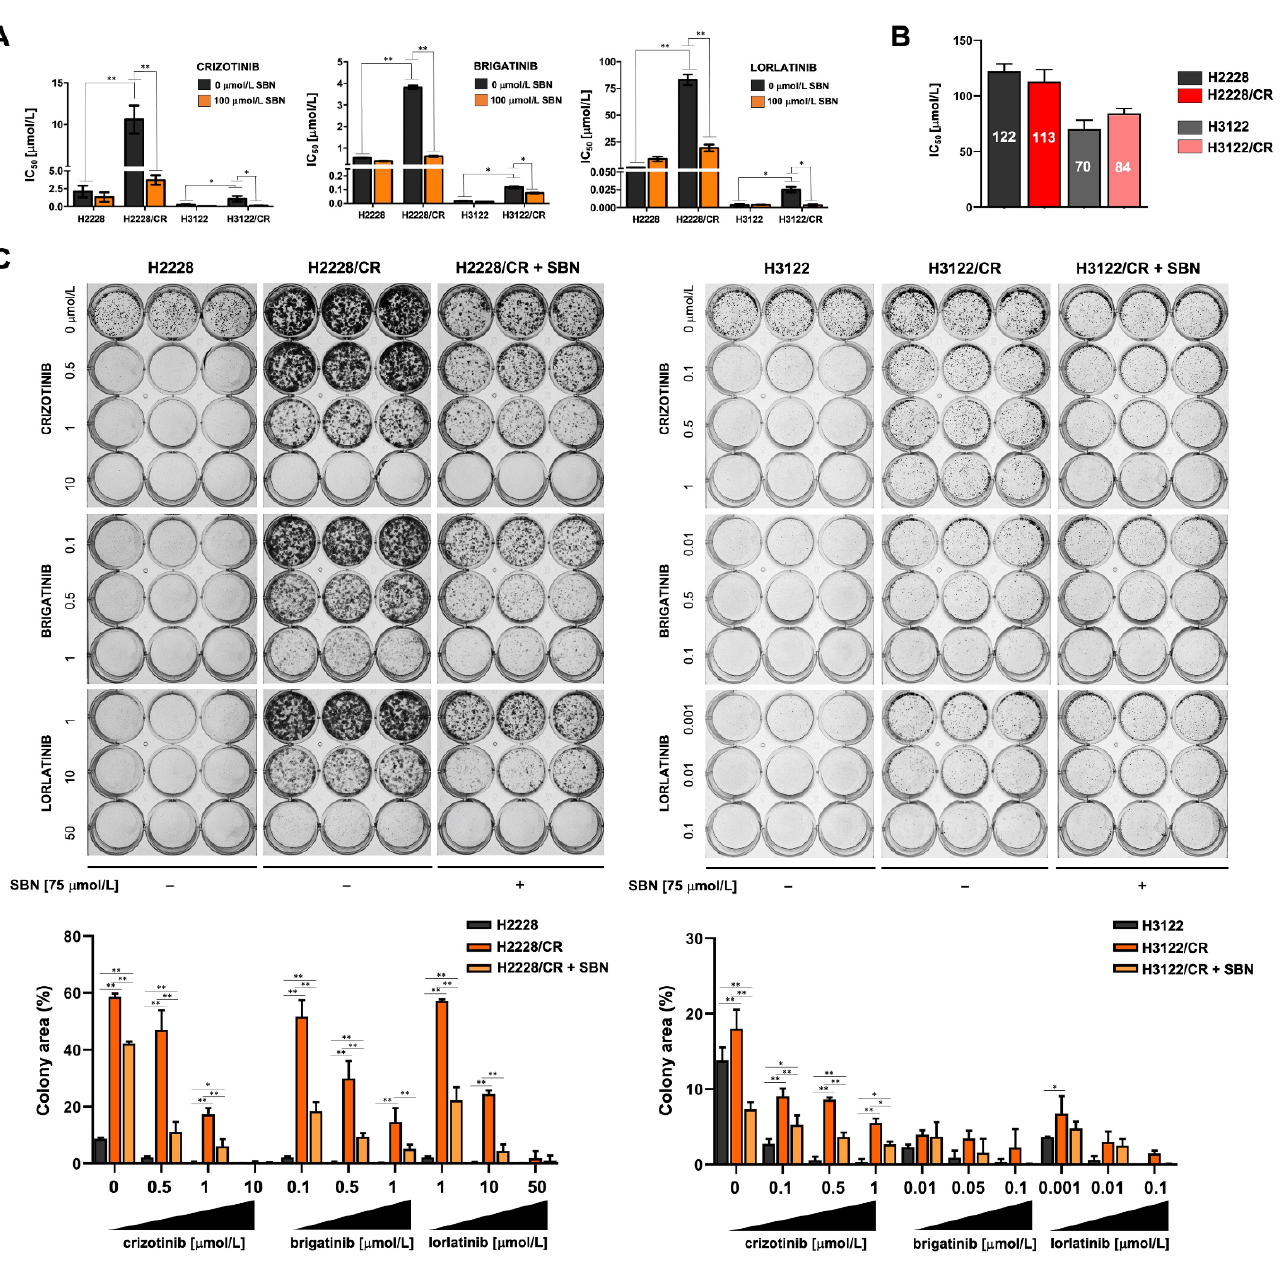
Figure 2. Sensitizing effects of silibinin against EMT-related acquisition of cross-resistance to multiple-generation ALK–TKIs. ( A ) Bar graphs showing the MTT-based IC 50 values of crizotinib, brigatinib, and lorlatinib for H2228/H2228CR and H3122/H3122CR cells calculated in the absence or presence of 100 µ mol/L of silibinin. ( B ) Bar graphs showing the MTT-based IC 50 values of silibinin in H2228/H2228CR and H3122/H3122CR cells. The results in A and B are presented as the means ( columns ) ± S.D ( bars ) ( n = 5, in triplicate). * p < 0.05 and ** p < 0.005, statistically significant differences; n.s. not significant. ( C ) Top: Representative images of clonogenic survival analyses (7 days) of H2228/H2228CR (left) and H3122/H3122CR cells (right) in response to graded concentrations of ALK–TKIs in the absence or presence of 75 μ mol/L silibinin. Bottom: Colony area (%) was calculated using the ImageJ plugin “ColonyArea”. The results are presented as the means ( columns ) ± S.D ( bars ) ( n = 3, in triplicate). * p < 0.05 and ** p < 0.005, statistically significant differences; n.s. not significant. Because exacerbated TGF β 1 signaling has been shown to drive the EMT-like pheno- type in H2228/CR cells [27], we evaluated the ability of silibinin to modulate